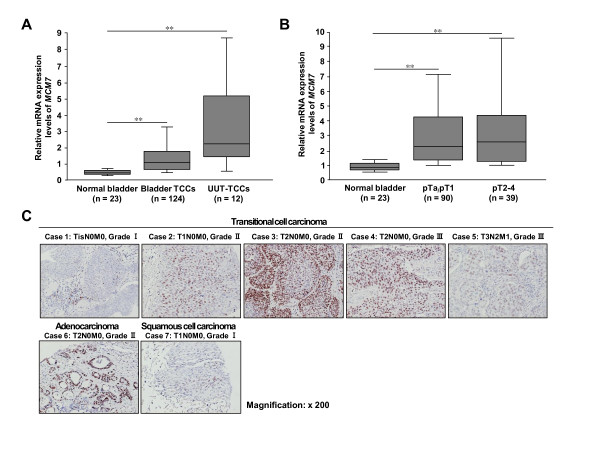
Elevated MCM7 expression in bladder cancer. (A) mRNA expression levels of MCM7 in 124 bladder transitional cell carcinomas (TCCs), 12 upper urinary tract transitional cell carcinomas (UUT-TCCs) and 23 normal bladder tissues analyzed by quantitative real-time PCR. Statistical analysis was done using Kruskal-Wallis test; P < 0.0001: Mann Whitney U-test; **, P < 0.0001. (B) Correlation between MCM7 expression and pathological tumor stages. Statistical analysis using Kruskal-Wallis test; P < 0.0001: Mann Whitney U-test; **, P < 0.0001. (C) Immunohistochemical analysis of MCM7 in bladder cancer tissues. Original magnification, ×200.